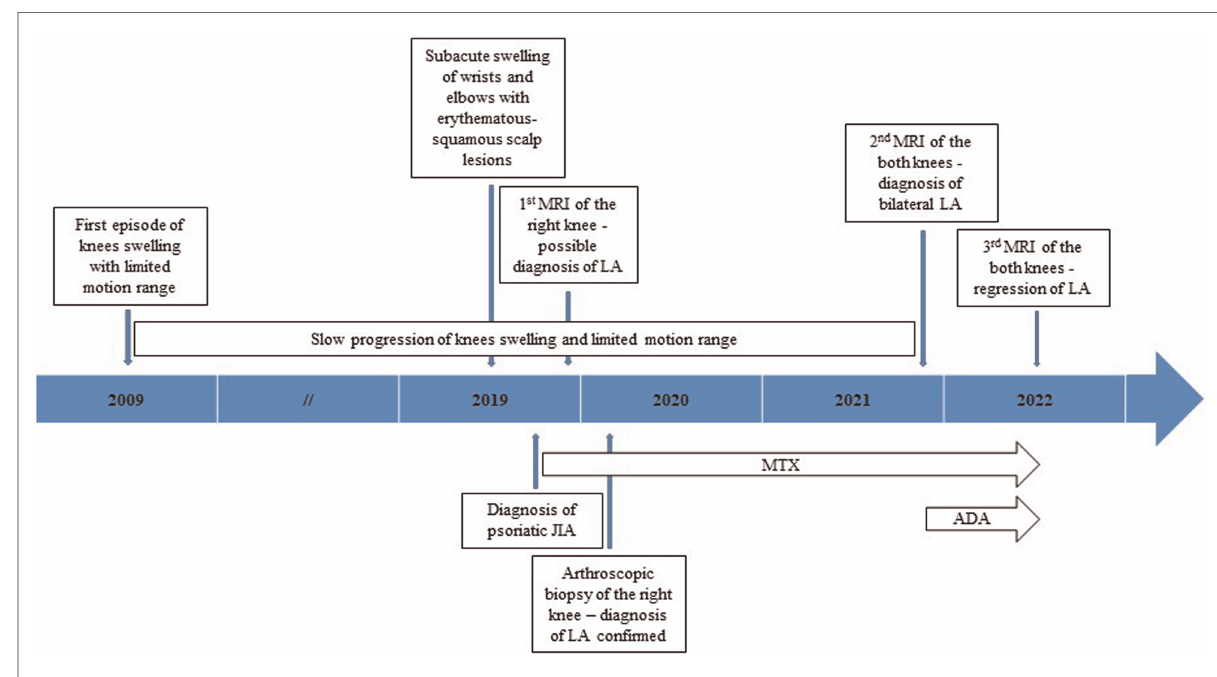
FIGURE 1 Diagram of disease progression, diagnostic evaluation, and therapeutic